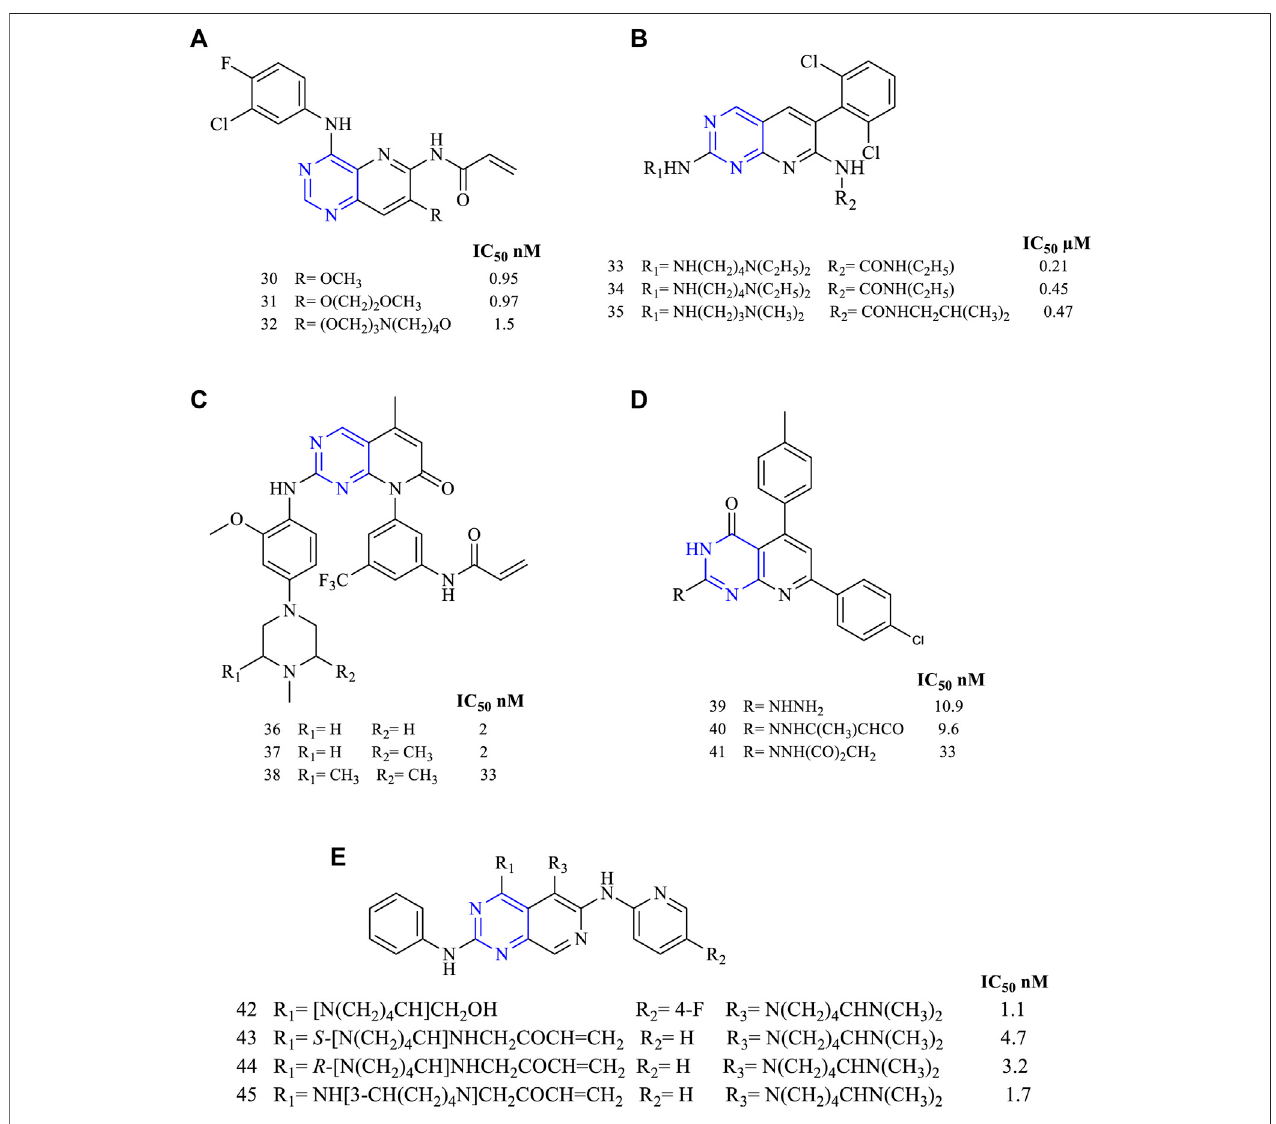
FIGURE 6 | Chemical structure of (A) 4,6,7-trisubstituted pyrido [3,2- d ]pyrimidine-based derivatives, (B) 6-aminopyrido [2,3- d ]pyrimidino-7-urea, (C) 2,5,8- trisubstituted pyrido [2,3- d ]pyrimidine, (D) trisubstituted pyrido [2,3- d ]pyrimidinone, and (E) 2,4,6-trisubstituted pyrido [3,4- d ]pyrimidine.